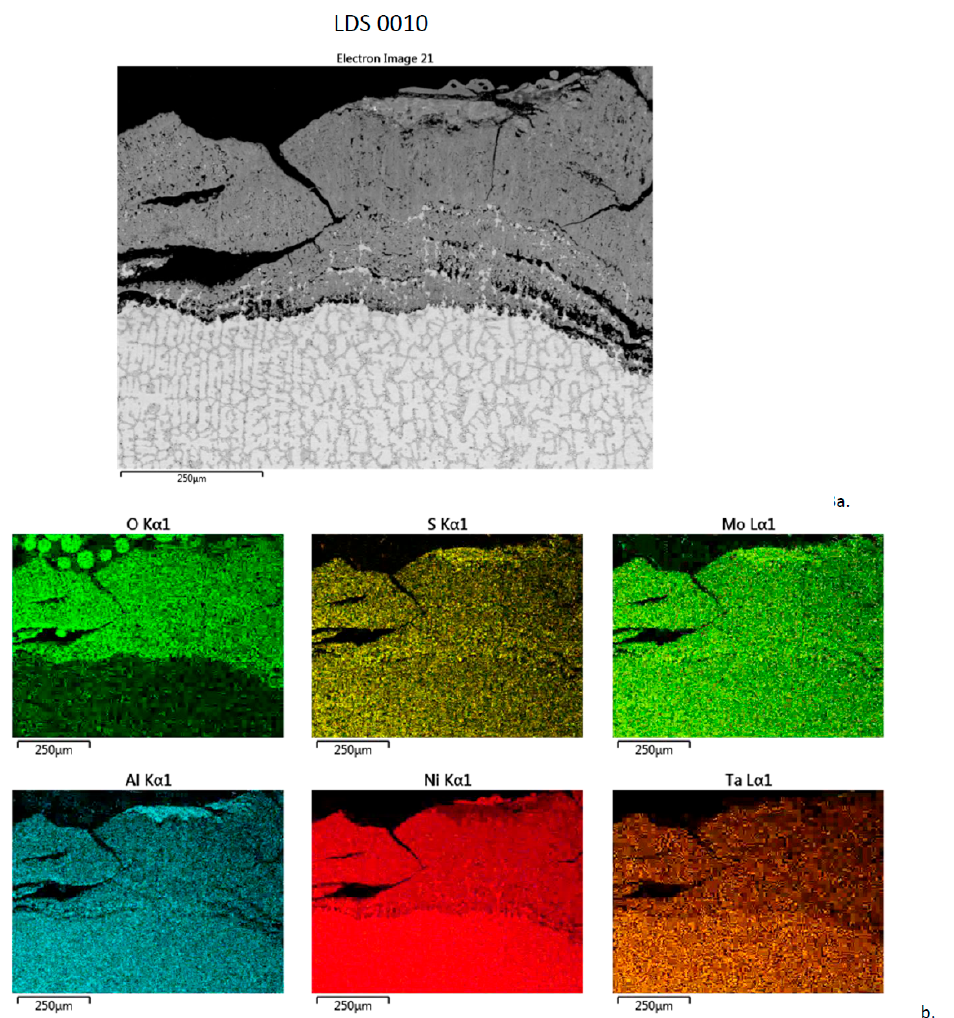
Figure 13. Cross-section of LDS 0010 sample after 300 h LTHC at 700 °C. ( a ) SE image showing extremely thick, cracked layer. ( b ) Elemental rasters for O, S, Mo, Al, Ni, Ta showing uniform chemical composition across the corrosion product.